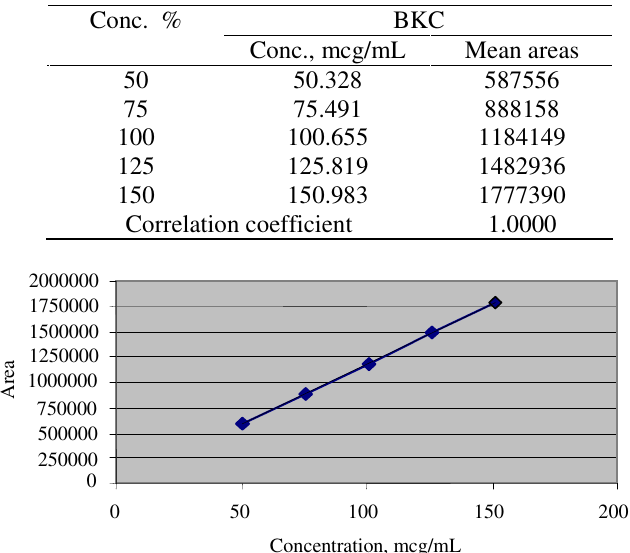
Table 5. Data of linearity study: (Correlation coefficient should not less than 0.990).